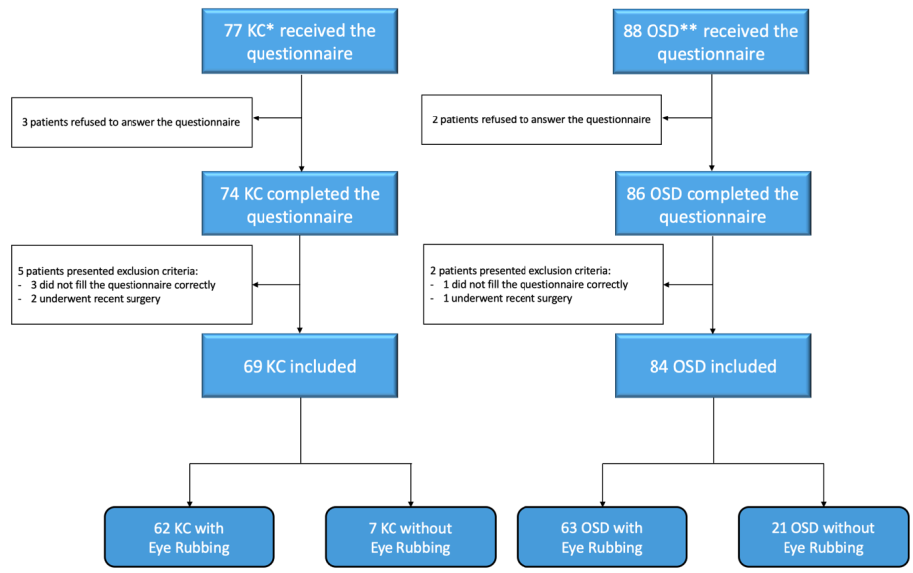
Figure 1. Flow chart of the study population. * KC: Keratoconus; ** OSD: Ocular Surface Disease. The average age was 39 ± 17 years and 61.4% of patients were female. Of the patients surveyed, 18 patients (11.8%) reported an addiction disorder and 38 patients (24.8%) reported a psychiatric disorder, mainly depression and anxiety. The characteristics of the study population are described in Table 1. Table 1. Characteristics of the study population: Keratoconus (KC) and Ocular Surface Disease (OSD) groups.